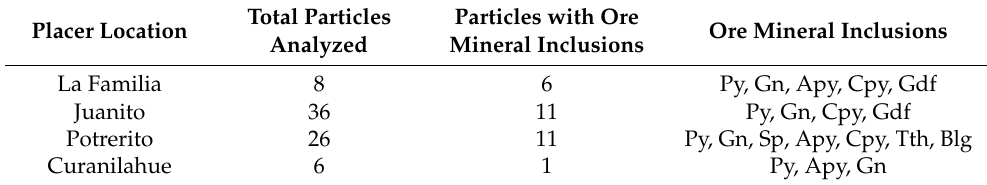
Ore Mineral Inclusions